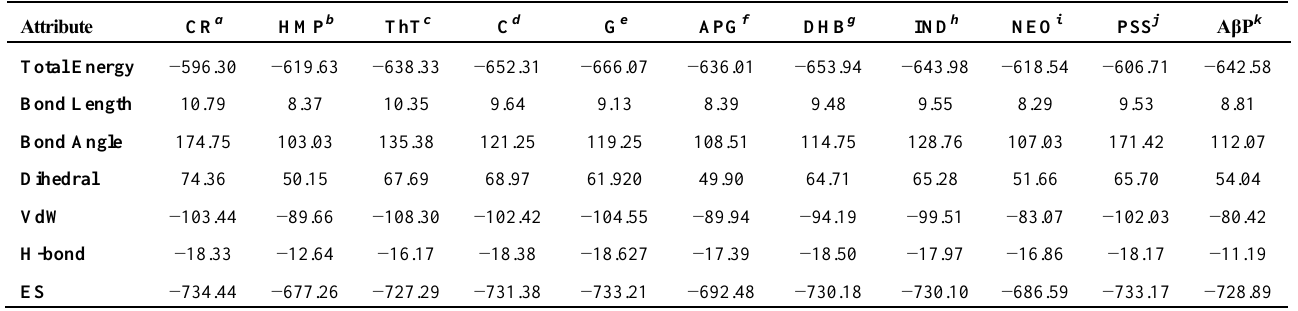
Table 2. Input Data for neural network training, computations and sensitivity testing.